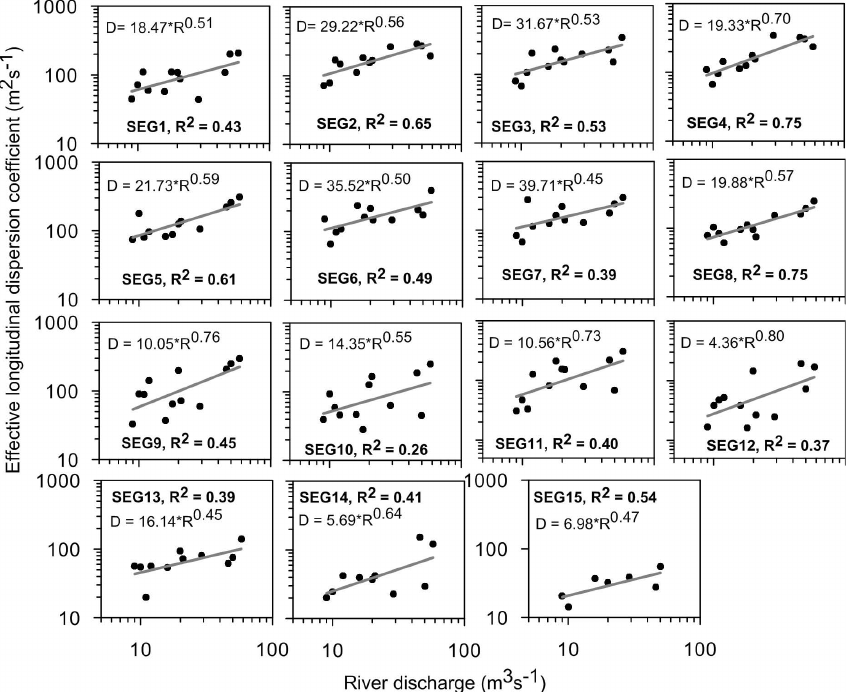
Fig. 6. Effective longitudinal dispersion coefficient ( D ) estimated at low water slack versus river discharge ( R ) at various positions along the Sumjin River Estuary.